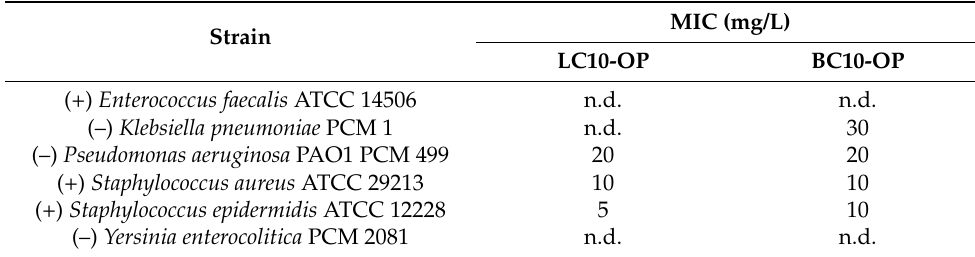
Table 1. Minimum inhibitory concentrations (MICs) determined for lipopeptides with a linear decanoyl chain (LC10-OP) or with a branched 4-methylnonanoyl chain (BC10-OP). PCM, Polish Collection of Microorganisms; ATCC, American Type Culture